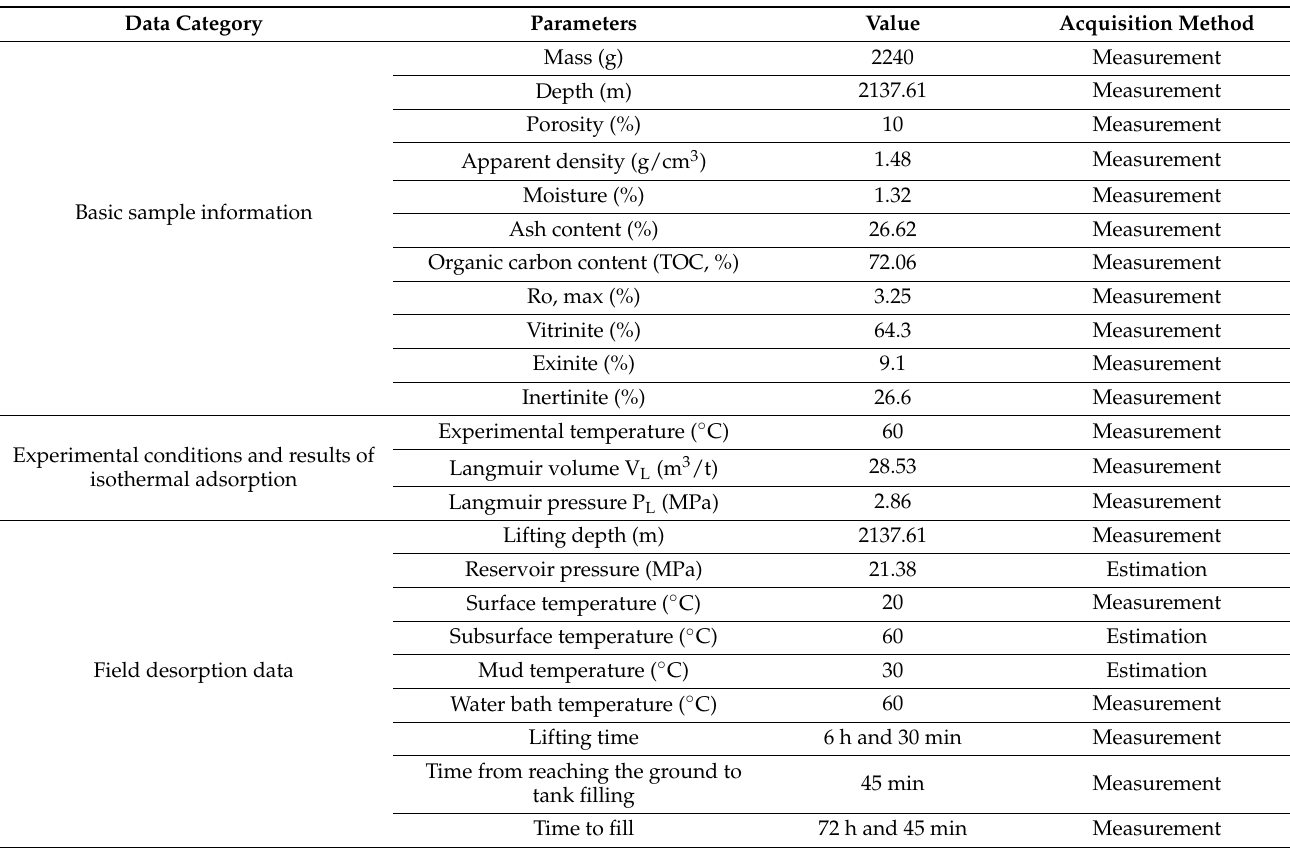
Table 1. Basic Parameter Table of Sample